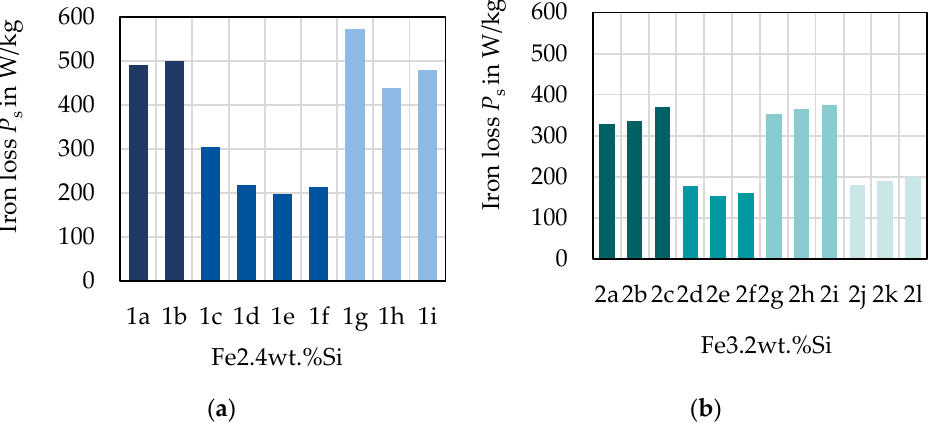
Figure 6. Iron loss at 1000 Hz for all studied 21 materials at 1.5 T: ( a ) Fe 2.4 wt % Si; ( b ) Fe 3.2 wt % Si.